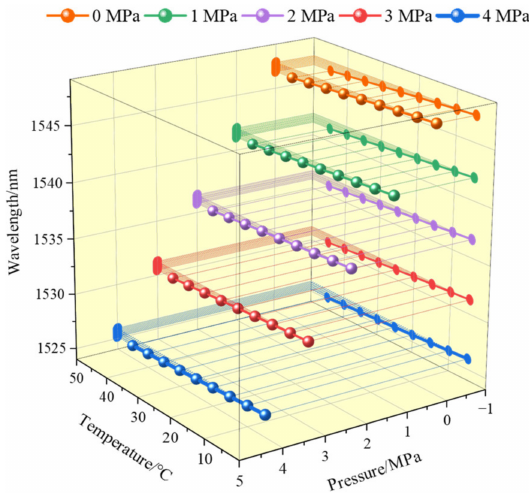
Figure 2. Schematic diagram of the test system.